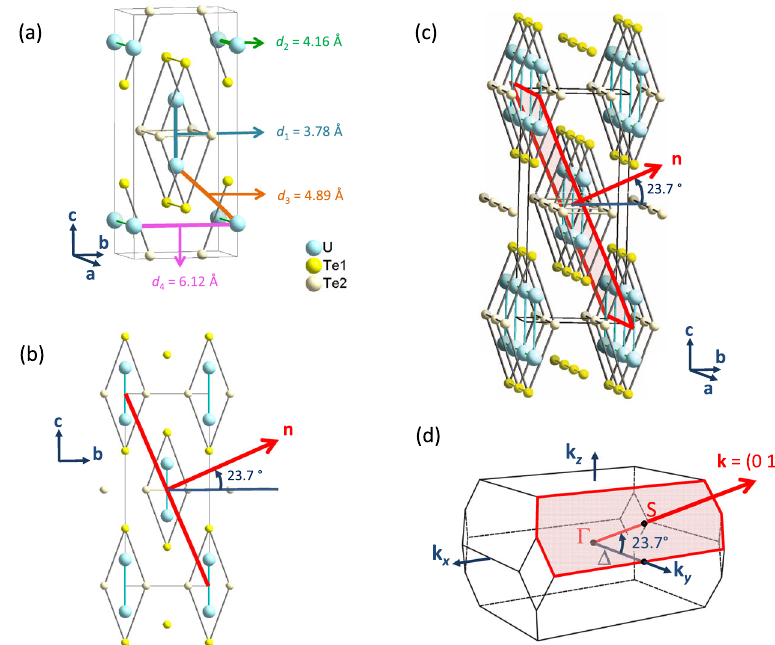
Fig. 5 Crystal structure and Brillouin zone of UTe 2 . a Elementary unit cell and identi fi cation of the four smallest U-U distances, b projection of the lattice structure in the ( b , c ) plane, c crystal structure extended to several unit cells emphasizing the network of two-leg ladders, and d Brillouin zone of UTe 2 . The vector n normal to a family of reticular (and cleaving) planes of Miller indices (0 1 1), with an angle θ = ( b , n ) = 23.7°, is indicated. These reticular planes are characteristic of the ladder structure. In reciprocal space, the corresponding wavevector k = (0 1 1), expressed in relative lattice units, is perpendicular to two planes of the Brillouin zone